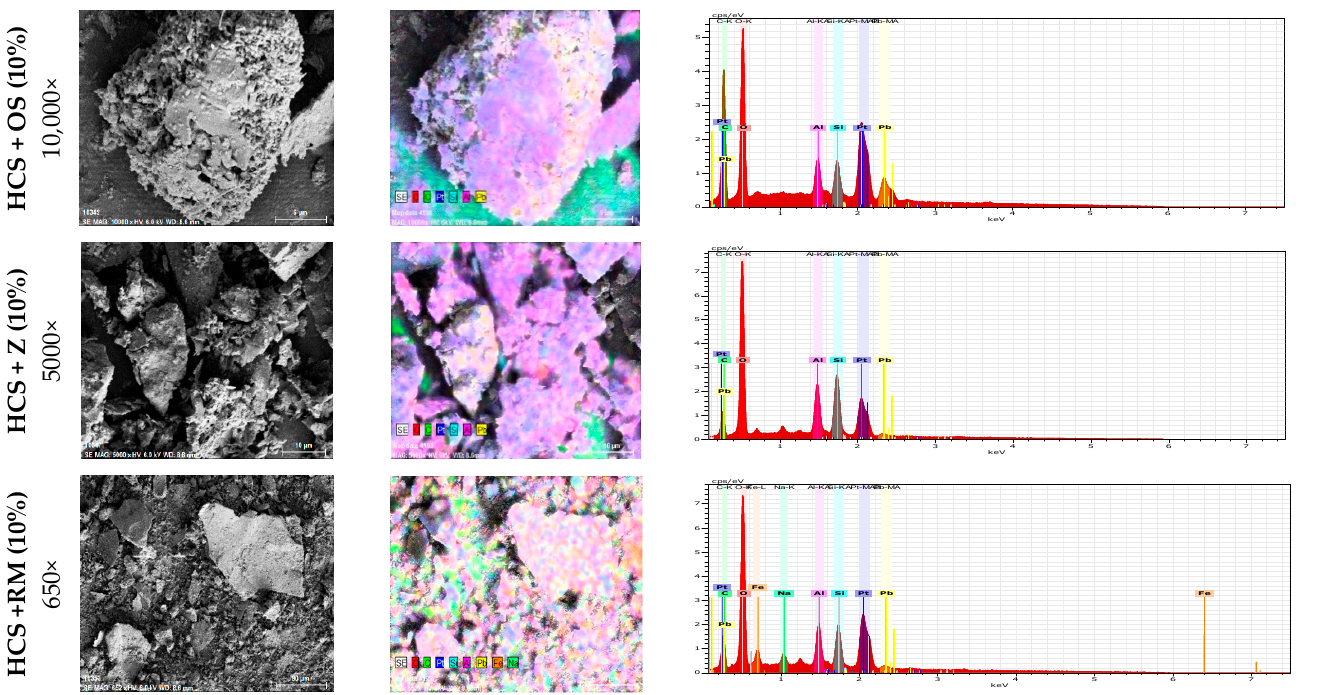
Figure 5. SEM–EDS analysis result for HCS treated with 10 wt% oyster shell, zeolite, and red mud.